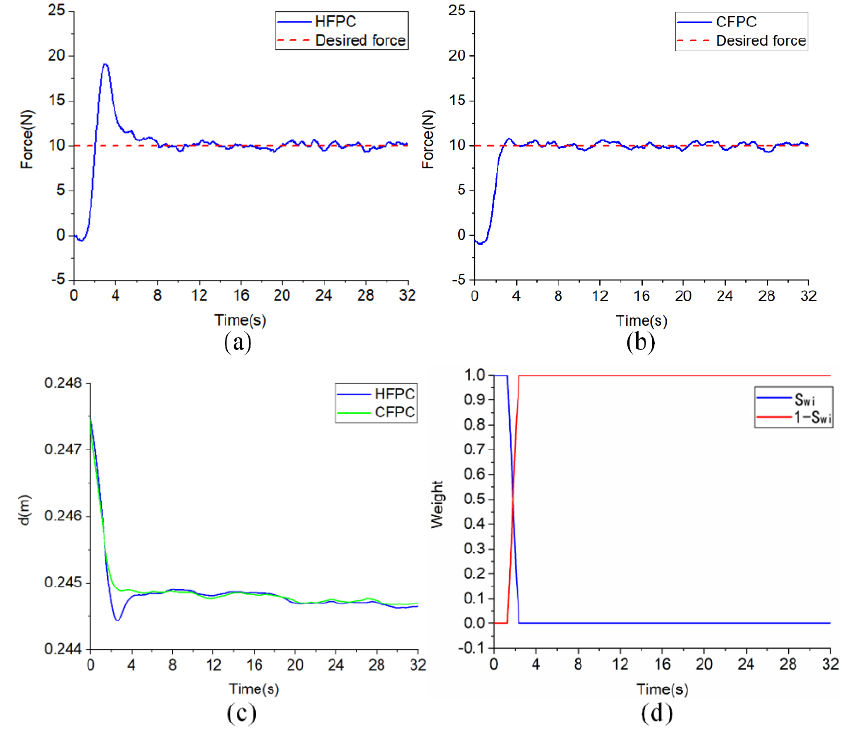
Figure 15. Grinding experiment on the plane. Force tacking using ( a ) the HFPC and ( b ) proposed CFPC methods. ( c ) Position tracking. ( d ) Weighted parameter s wi .